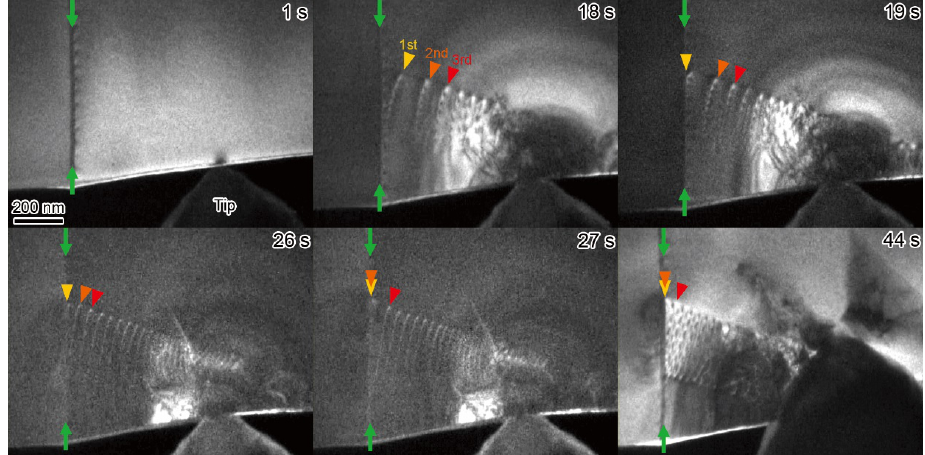
Figure 73. Sequential dark-field TEM images captured from the movie recorded during the nanoindentation experiment. The line contrasts indicated by the green arrows correspond to the Σ 5 grain boundary. The positions of the leading three lattice dislocations are indicated by the triangles. The indenter tip was gradually inserted from 0 s to 42 s, and the specimen edge was fractured at 43 s. The dislocation motion was strongly impeded by the grain boundary, which resulted in the dislocation pile-up. In this experiment, the 1st and 2nd dislocations and the lower part of the 3rd dislocation were trapped on the grain boundary plane even after the external stress was removed. Adapted with permission from Ref. [276].